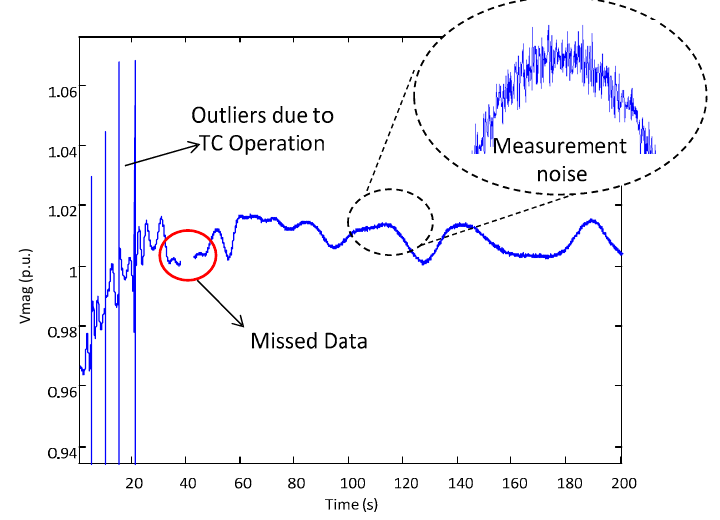
Figure 2. Problems in PMU voltage measurement.